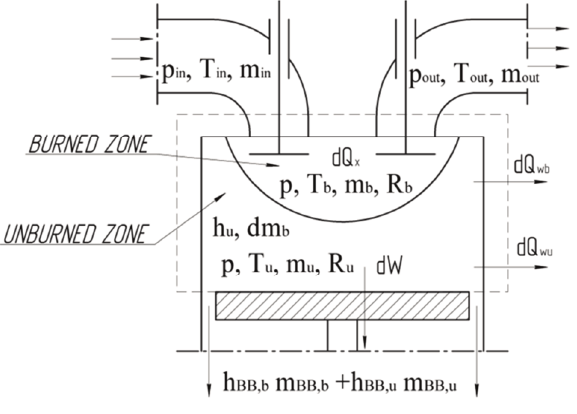
Fig. 5. Thermal balance of the two-zone